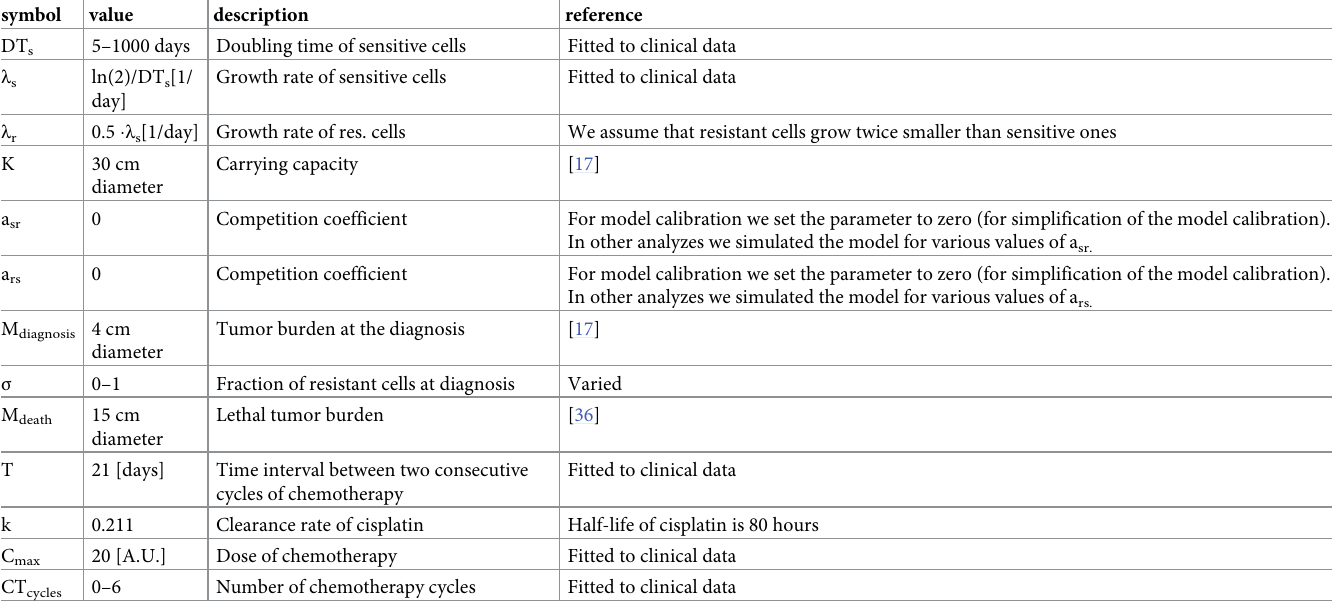
Table 3. List of parameters of the mathematical model for NSCLC